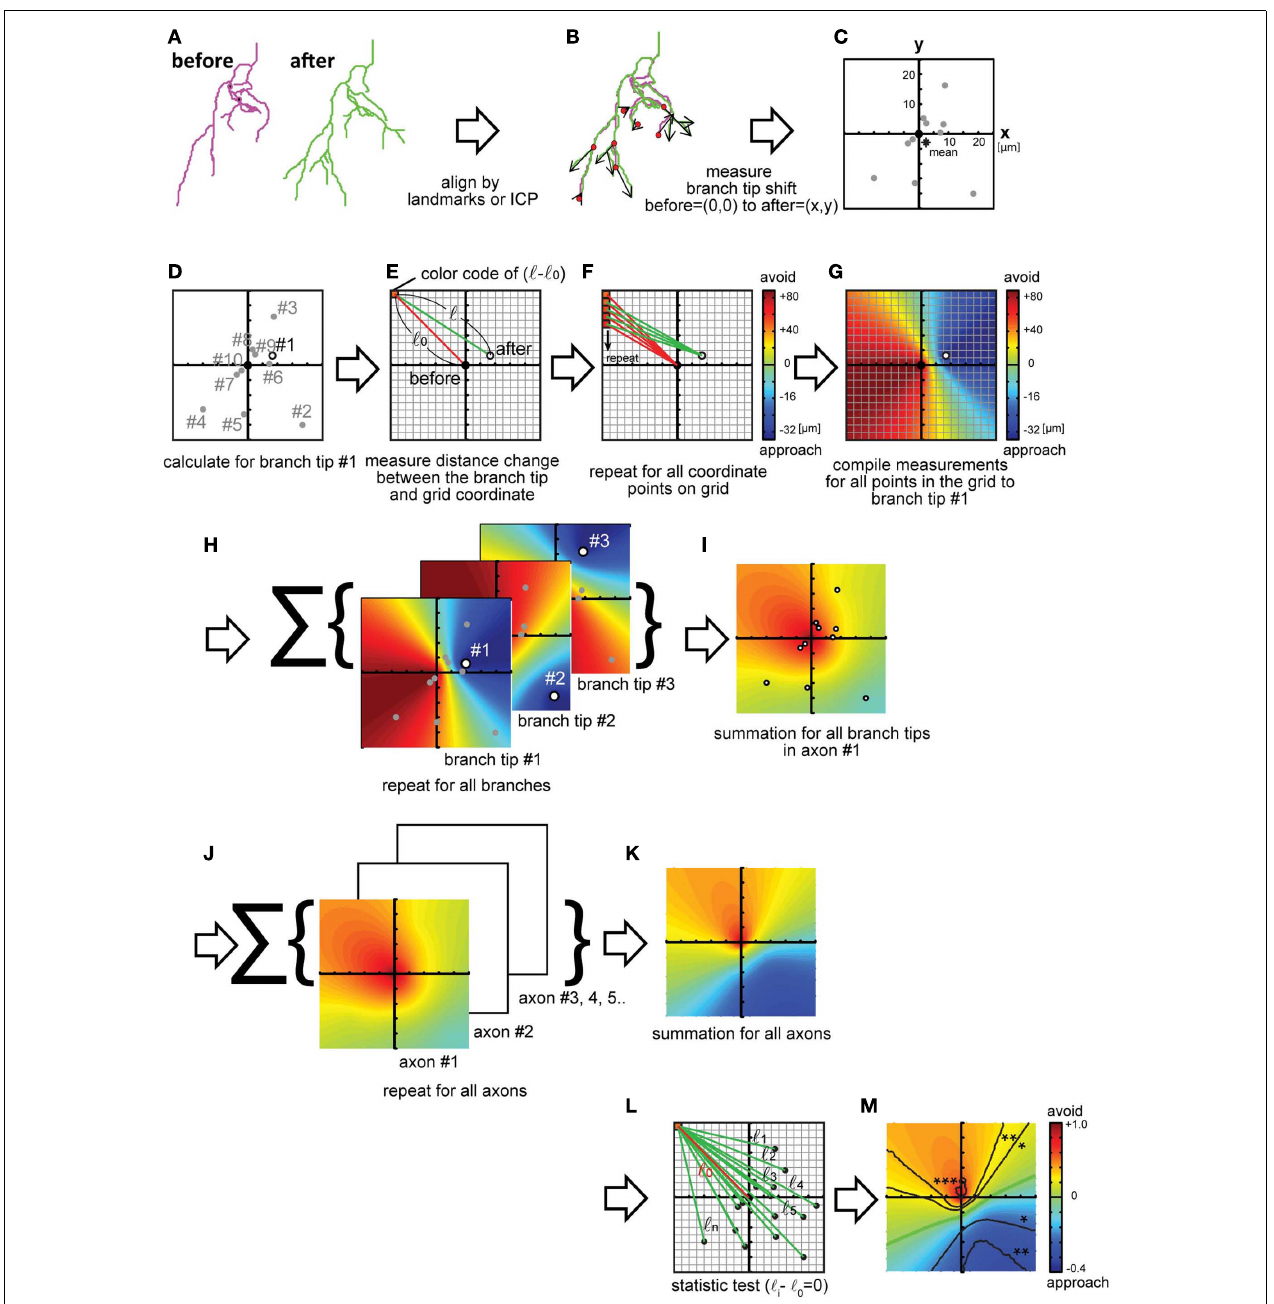
FIGURE 2 | Calculations to generate a displacement maps. (A) Traced three-dimensional filament data at different time points are aligned by landmarks in the tissue or by cellular morphology, followed by an iterative closest point (ICP) algorithm. (B,C) Displacement vectors for each branch tip were calculated (B) and plotted on an x,y coordinate map (C) .The origin represents no change in branch tip position. Star: the mean of all displacement vectors. (D–G) Calculation of changes in position for one of the branch tips [ (D) circle, marked #1] relative to each pixel in the coordinate. One of the pixels is shown [ (E) : red]. Changes in branch tip distances in the spatial map are calculated by subtracting the distance between each pixel (red box) and the origin, the position of the branch tip at Day 1 (before: red line = l 0 ) from the distance between the same pixel position and the x , y location of the